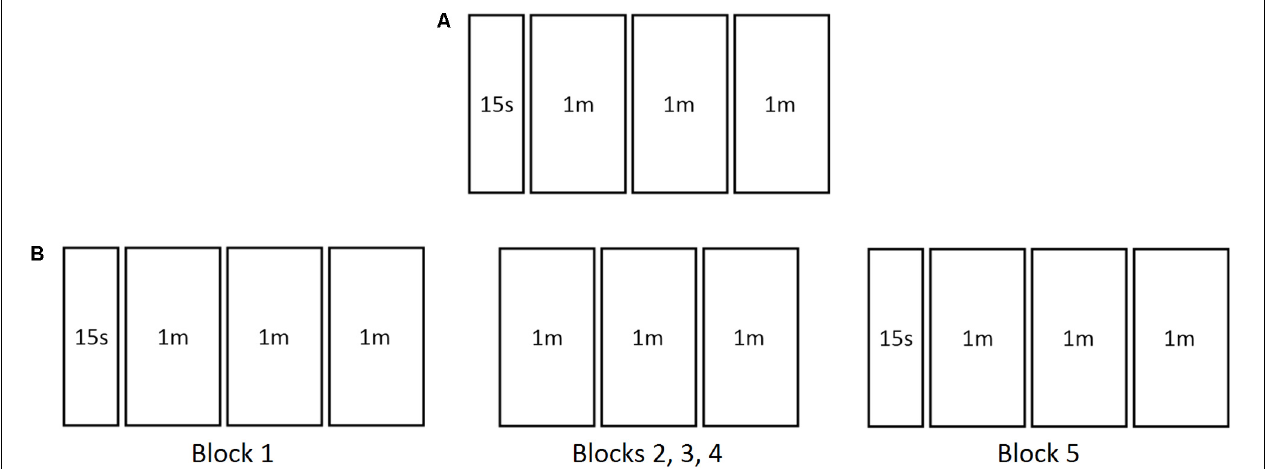
FIGURE 2 | The two versions of the game used in the two present studies. The version used in Study 1 comprised only one block (A) , while the version used in Study 2 comprised five blocks (B) . 15s, 15 s familiarization trial; 1m, 1 min practice trial.